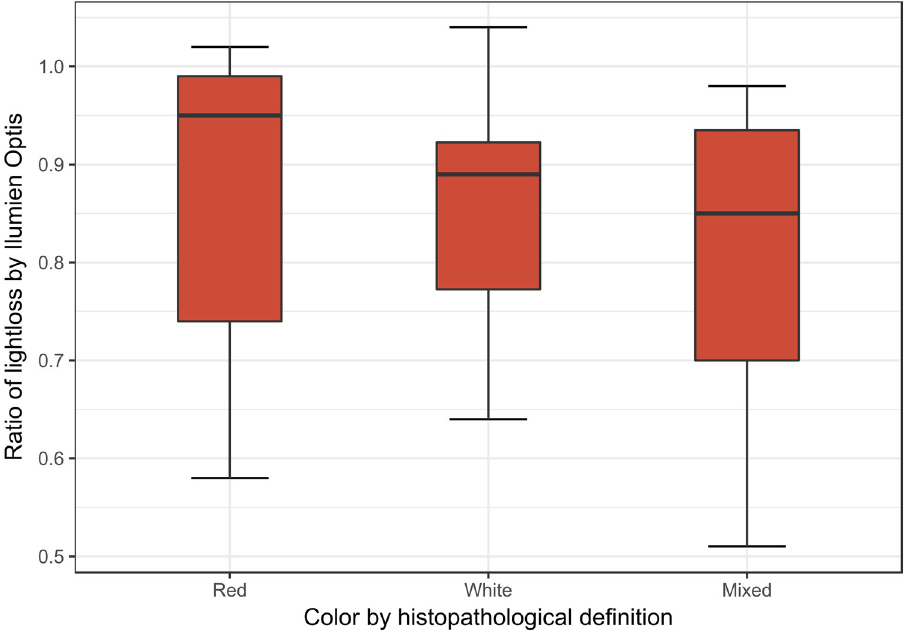
Fig 3. Ratio of lightloss by Ilumien Optis software in the different histopathological defined colours.